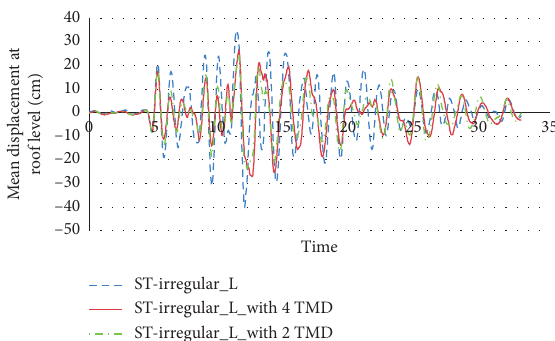
Figure 21: Displacement of the ten-story irregular L-shaped model with 2 and 4